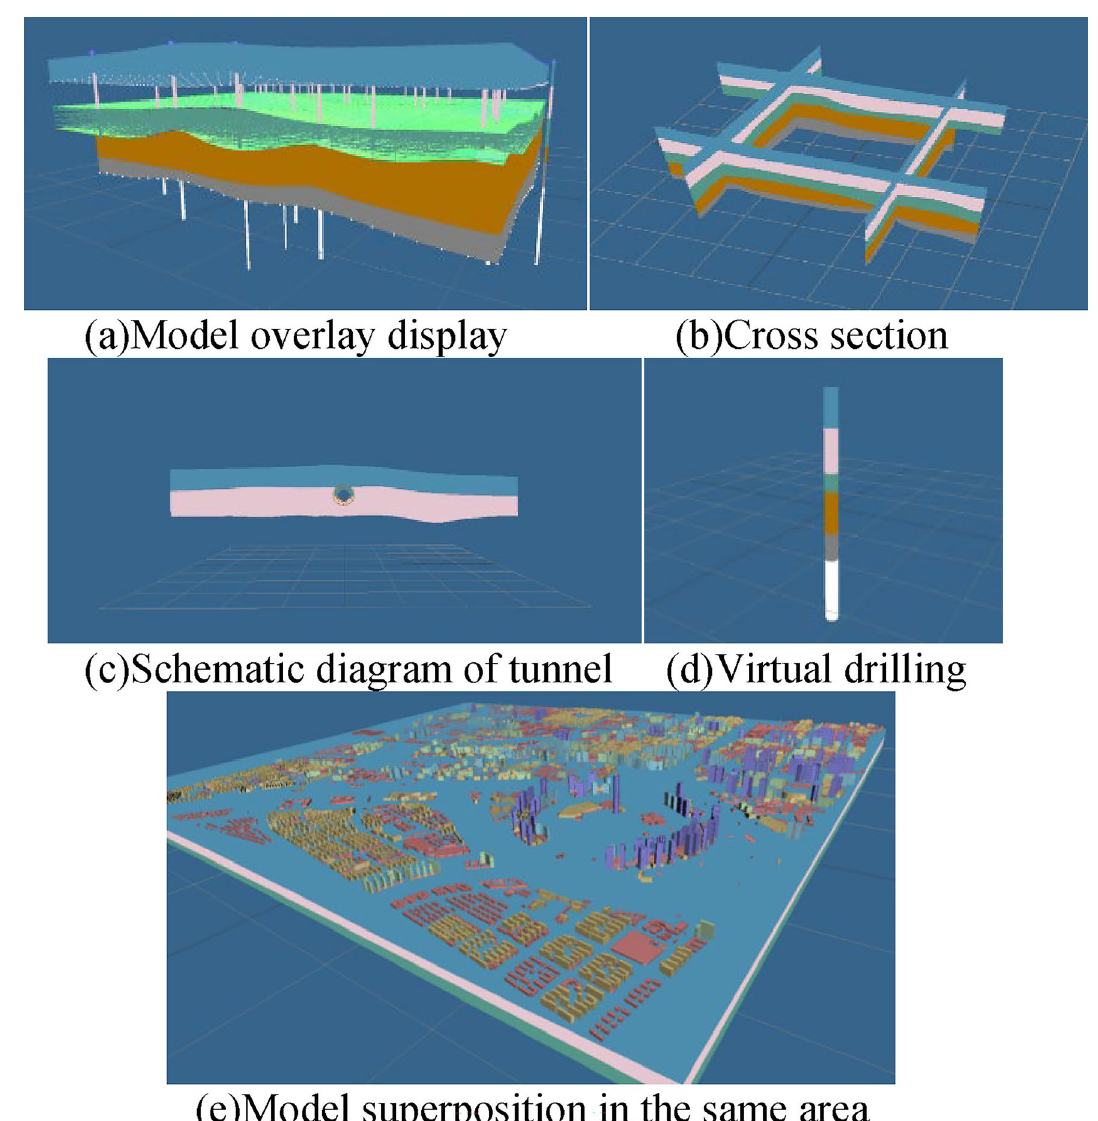
Figure 19. Prototype system model